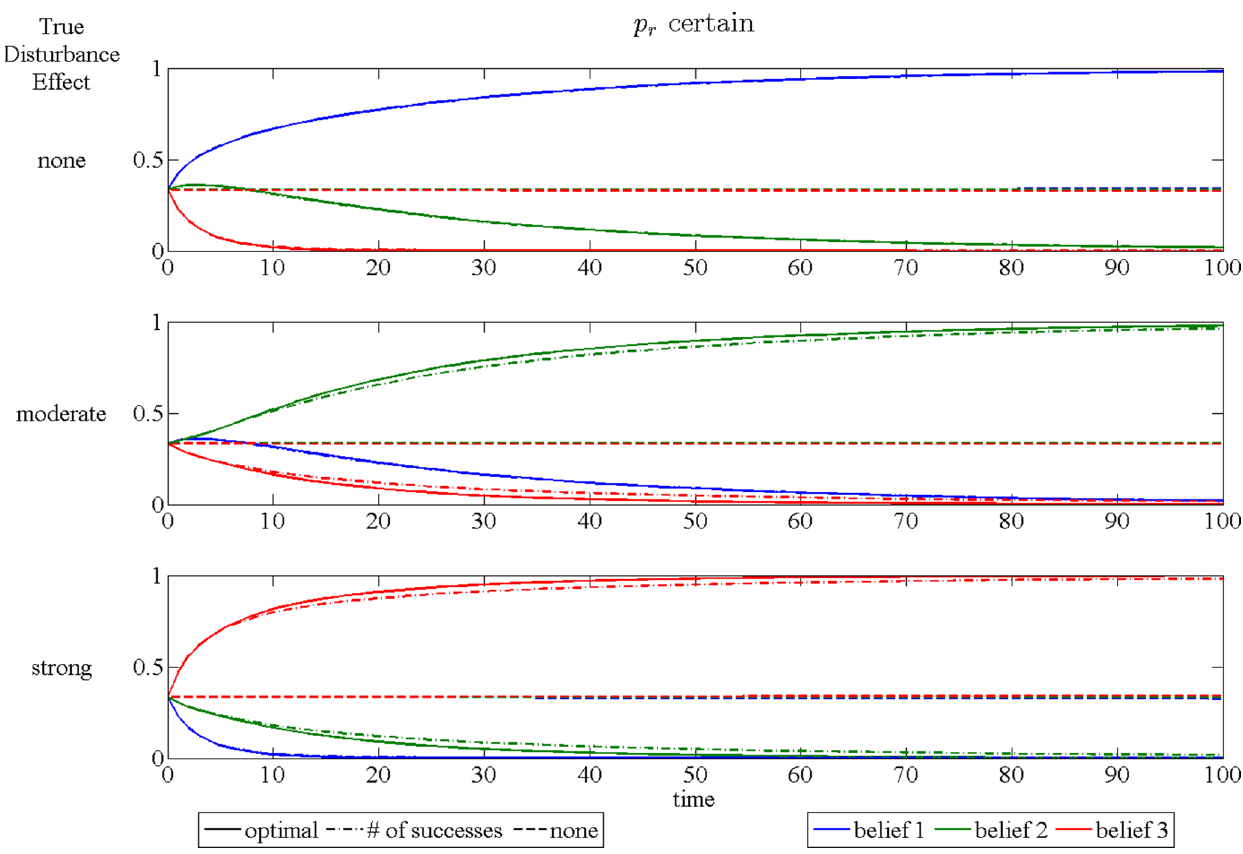
Figure 6. Time paths of expected beliefs when p r is known. The three subplots represent cases for each of the three possible disturbance effect models. Each plot shows time paths of expected beliefs over 100 years. Line color is associated with the belief in a specific disturbance effect: blue – no disturbance, green –moderate disturbance, red – strong disturbance. Line type represents the signal used for updating beliefs: solid – full information, dash/dot – number of successes only, dashed – no signal.